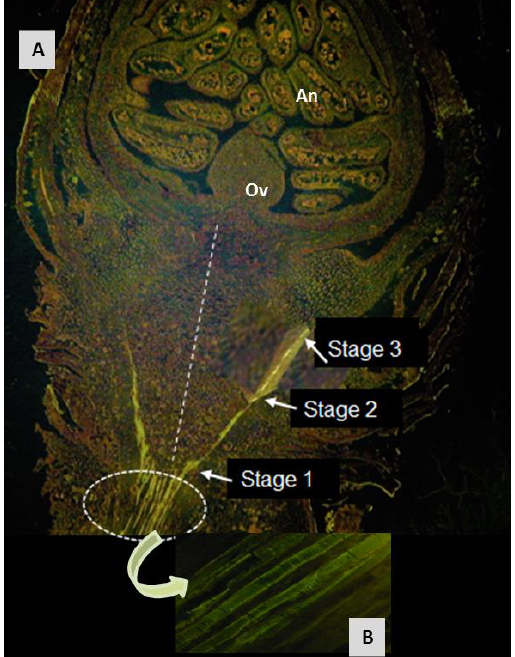
Figure 5. Longitudinal sections of apricot flower buds. ( A ) ( × 200) Fluorescent acridine orange reaction shows the xylem vessels along the flower bud axis (vertical dotted line): stage 1 = at the base of the axis; stage 2 = at 1 / 2 of the axis; stage 3 = at 3 / 4 of the axis. Dotted circled area shows the pulvinar juncture; Ov (Ovary), An (Anther). ( B ) ( × 400) Detail of xylem vessels. All drought treatments (S1, S2, S3) caused a significant slower xylem progression than control trees in which, a more regular xylem di ff erentiation was observed (Figure 6).